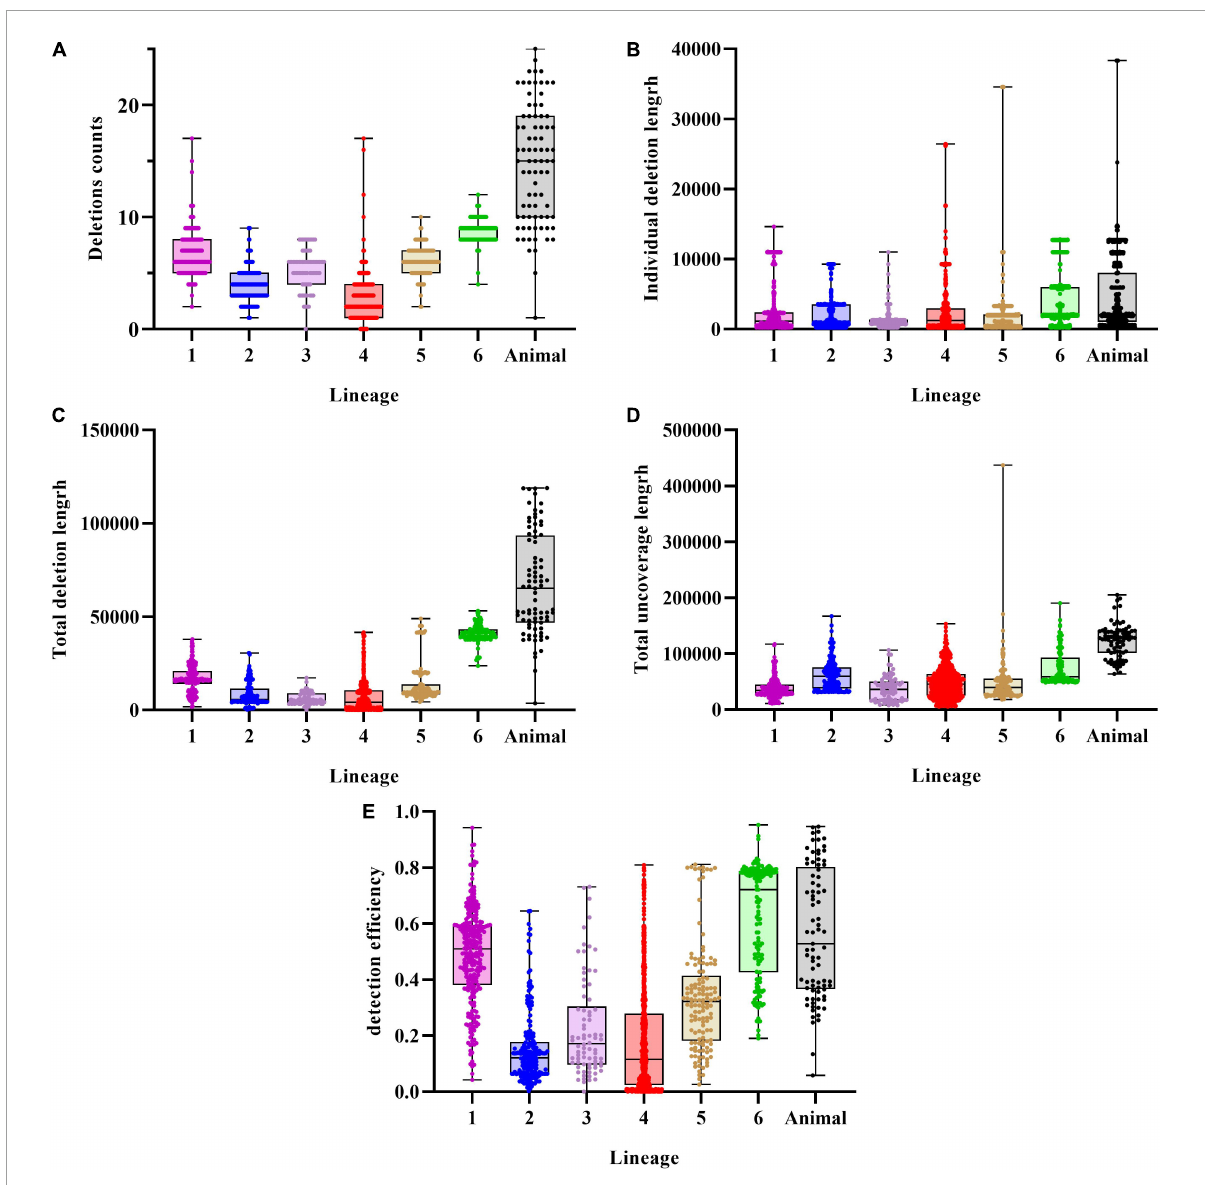
FIGURE2 Characteristics of deletions in MTBC strains. (A) Deletions per genome distribution among MTBC strains. (B) Individual deletion length distribution among lineages. (C) Total deletions length per genome distribution among MTBC strains. (D) Total uncoverage length per genome distribution among MTBC strains. (E) Detection efficiency of deletions distribution among MTBC